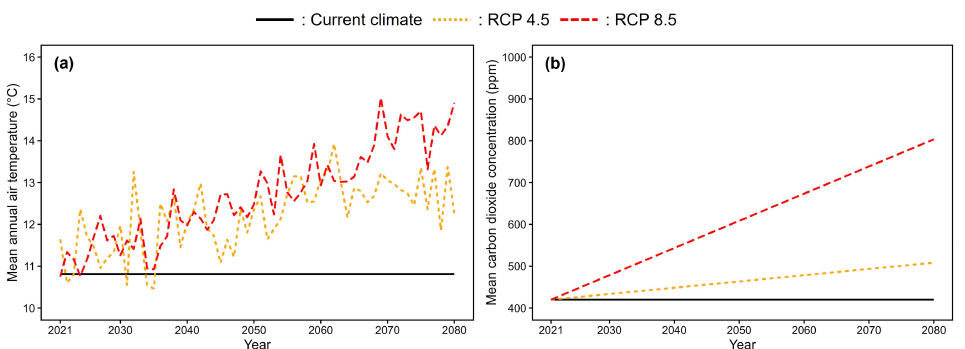
Figure A1. Mean annual precipitation from 2021 to 2080 under current climate (black solid line), RCP 4.5 (orange dotted line), and RCP 8.5 (red dashed line) scenarios.